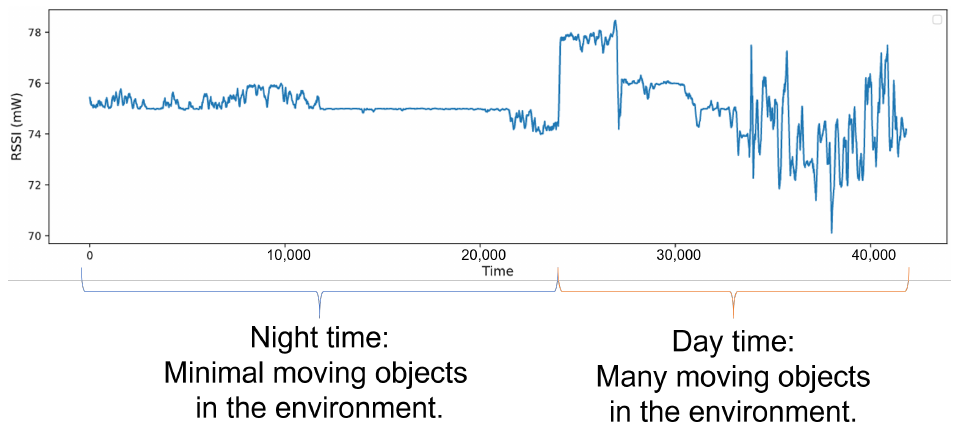
Figure 1. RSSI values of an IoT device deployed in a residential property with routine movements of occupants in a 24 h